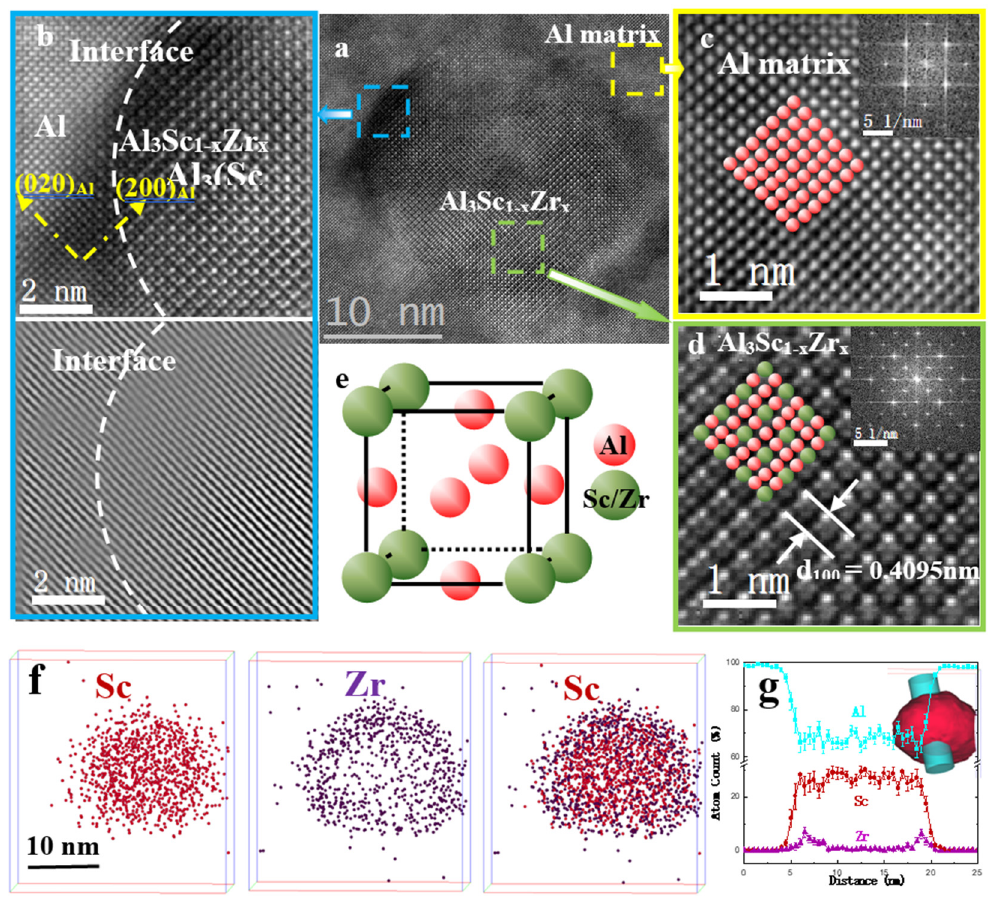
Figure 1. High-resolution HAADF STEM images and 3DAPT dataset confirming the Al 3 Sc 1 − x Zr x nanoparticles with an ordered L1 2 core-shell structures and full lattice coherence. ( a ) High-resolution STEM images of Al 3 Sc 1 − x Zr x ; ( b – d ) the filtered HRTEM HAADF STEM images of the interface, α (Al) matrix, nanoparticles, respectively, along with the inset showing fast Fourier transform (FFT) patterns; ( e ) crystal structure of L1 2 -Al 3 Sc 1 − x Zr x ; ( f ) Atom probe tomography reconstruction of the particles; ( g ) atom distribution across the spherical particles along the blue bar as the inset.